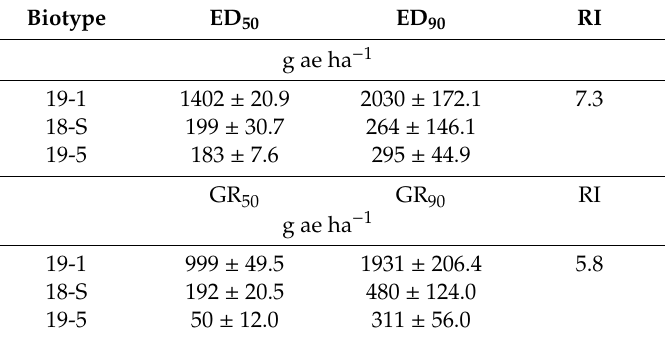
Table 1. Values of effective dose of glyphosate for 50% and 90% estimated plant death (ED 50 and ED 90 ) and fresh biomass reduction (GR 50 and GR 90 ) for the putative GR biotype (19-1) and the two susceptible reference biotypes (18-S and 19-S), plus Resistance Index (RI) of the putative GR biotype.